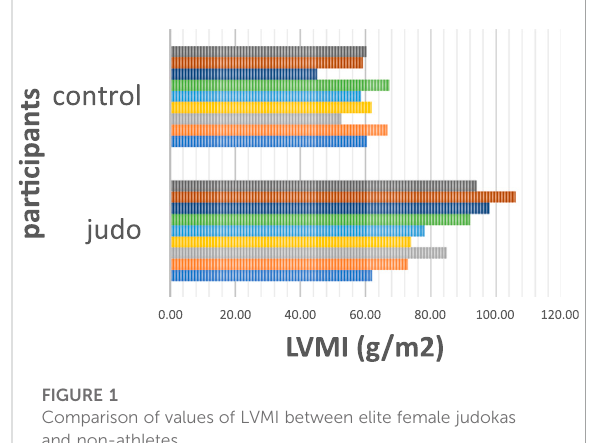
FIGURE 1 Comparison of values of LVMI between elite female judokas and